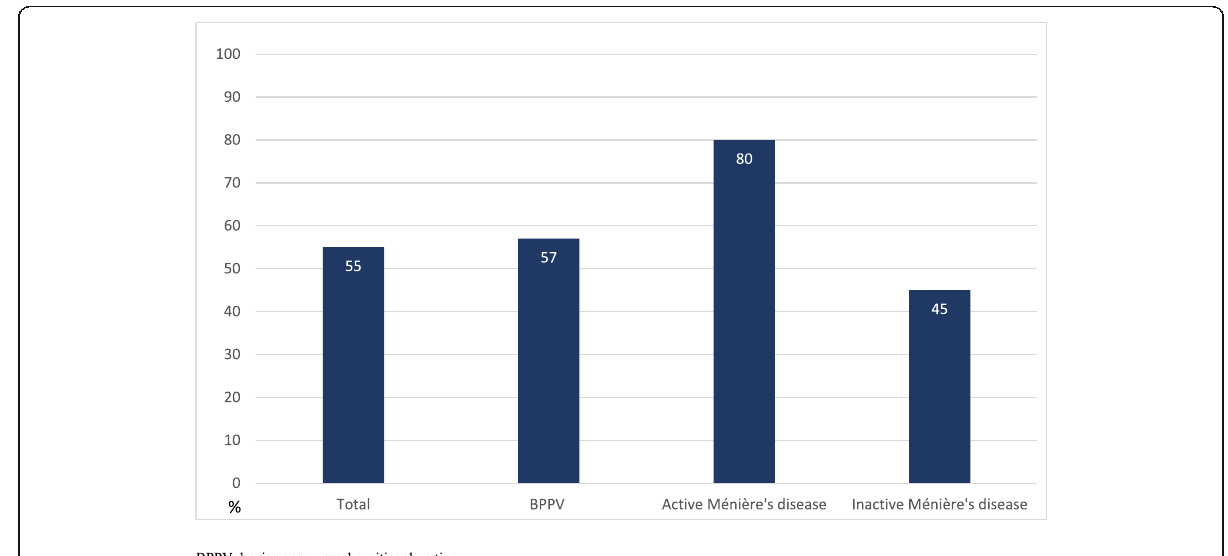
Fig. 2 Percentage of patients that corresponded to the deviation side of the bucket test and the vestibular